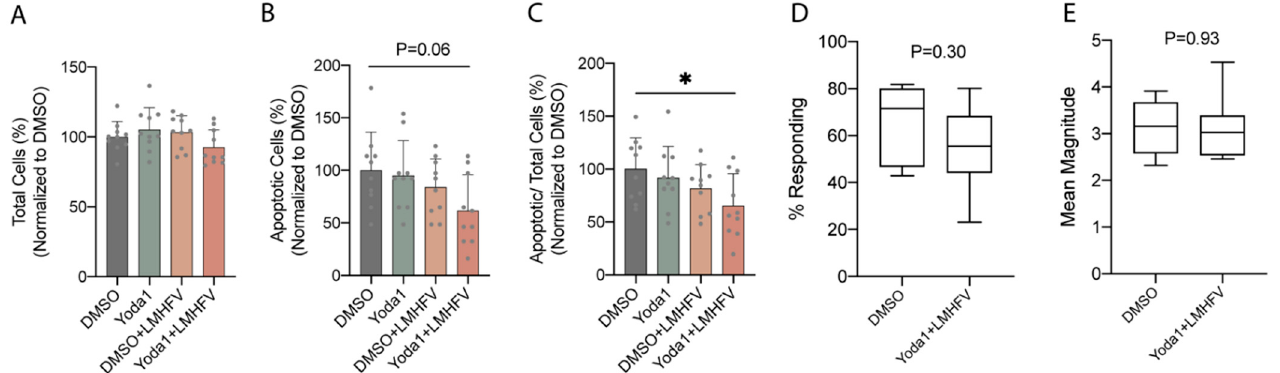
Figure 7. Breast cancer cells stimulated with combined treatment decreased the percentage of apoptotic osteocytes but showed no significant effect on the intracellular calcium influx of osteocytes in response to OFF. ( A ) Total MLO-Y4, ( B ) apoptotic MLO-Y4, and ( C ) apoptotic MLO-Y4 over total MLO-Y4 after 3-day incubation of MLO-Y4 in CM from MDA-MB-231 stimulated with DMSO, monotreatments, or combined treatment ( n = 10). Normalized to DMSO control. ( D ) Intracellular calcium response percentage and ( E ) mean magnitude of MLO-Y4 under 2 Pa OFF after 3-day incubation of MLO-Y4 in CM from combined treatment stimulated MDA-MB-231 compared to DMSO ( n = 7–8). * p < 0.05.